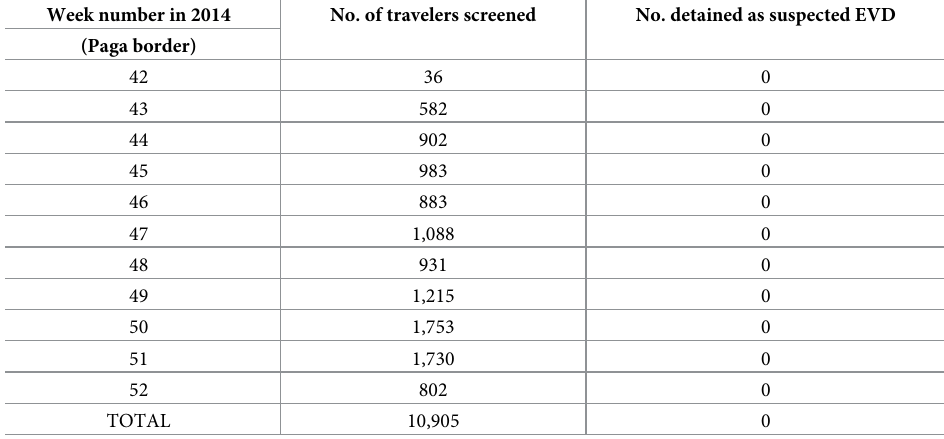
Table 1. Epidemiological weekly reports on screened travelers for EVD in Upper East Region, Ghana, 2014.